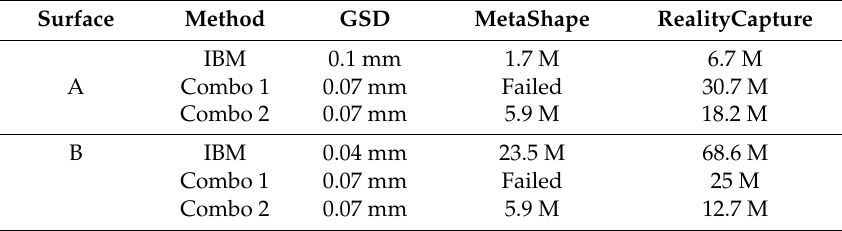
Table 4. The number of vertices (in millions) in each of the 3D models generated. From these we can assume that the RealityCapture models are more accurate than the MetaShape models, though this should also be assessed visually. The Ground Sampling Distance (GSD) values indicate the level of details in the pictures the models are based on. These were calculated using Ground Sample Distance Calculator on